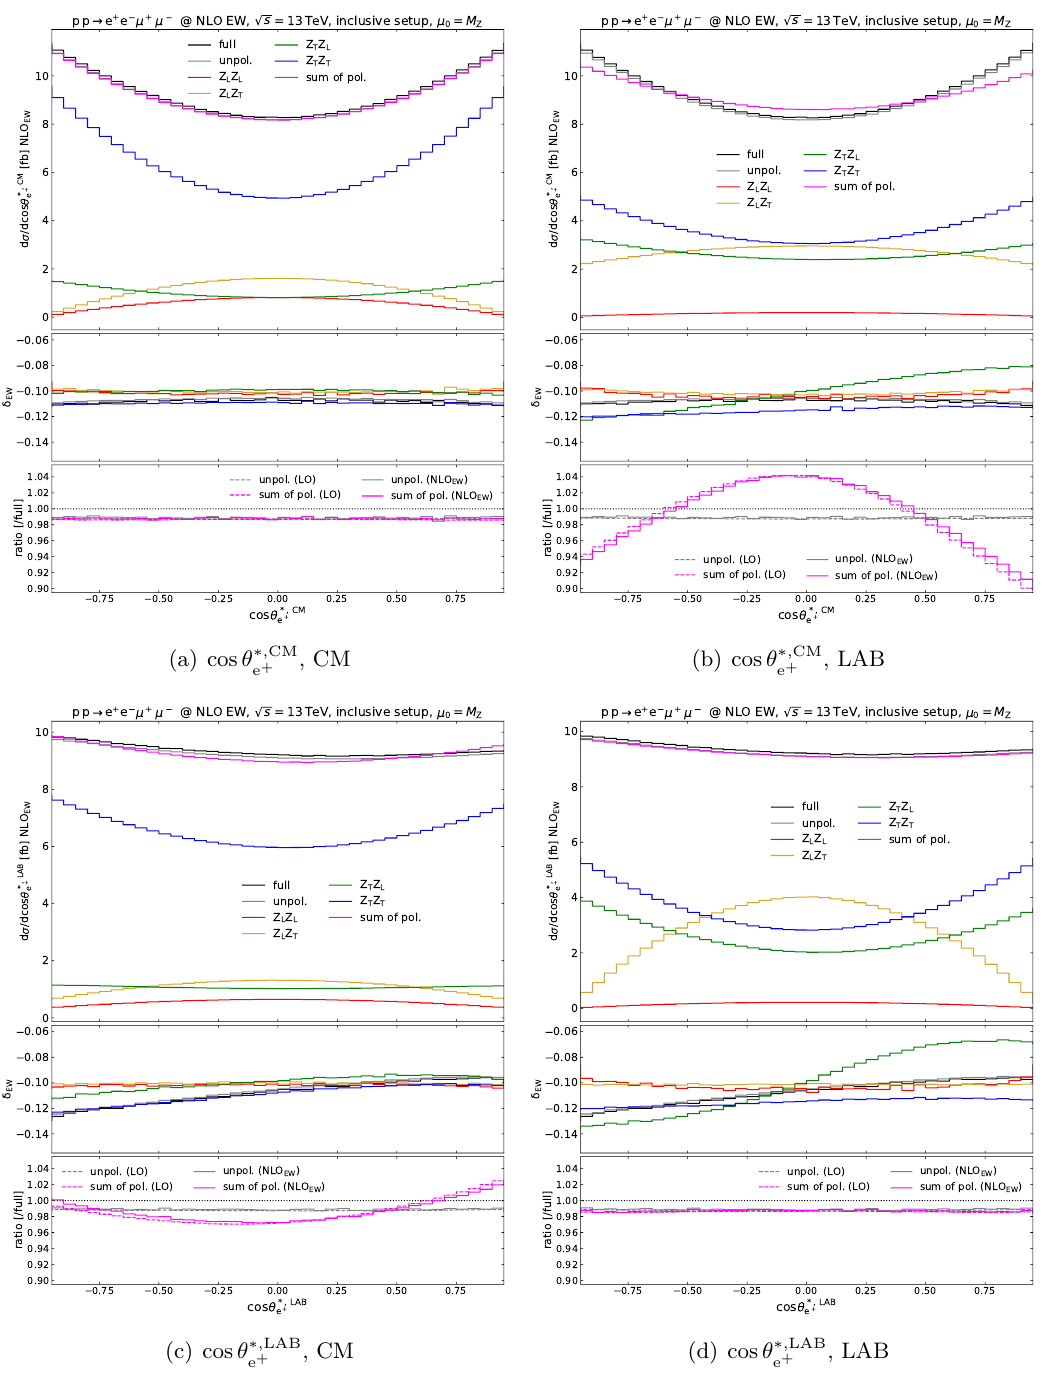
Figure 6 . Distributions in the cosine of the polar decay angle θ ∗ of the positron in its corresponding Z-boson rest frame computed w.r.t. the Z-boson spatial direction in the CM frame (a,b) and in the LAB frame (c,d). Polarizations are defined in the CM (a,c) and in the LAB (b,d) frame. Unpolarized and doubly-polarized results are shown for ZZ production at the LHC in the inclusive setup described in section 2.5. From top down: NLO differential cross-sections, EW corrections EW relative to LO ( δ ), and ratios of DPA over the full EW